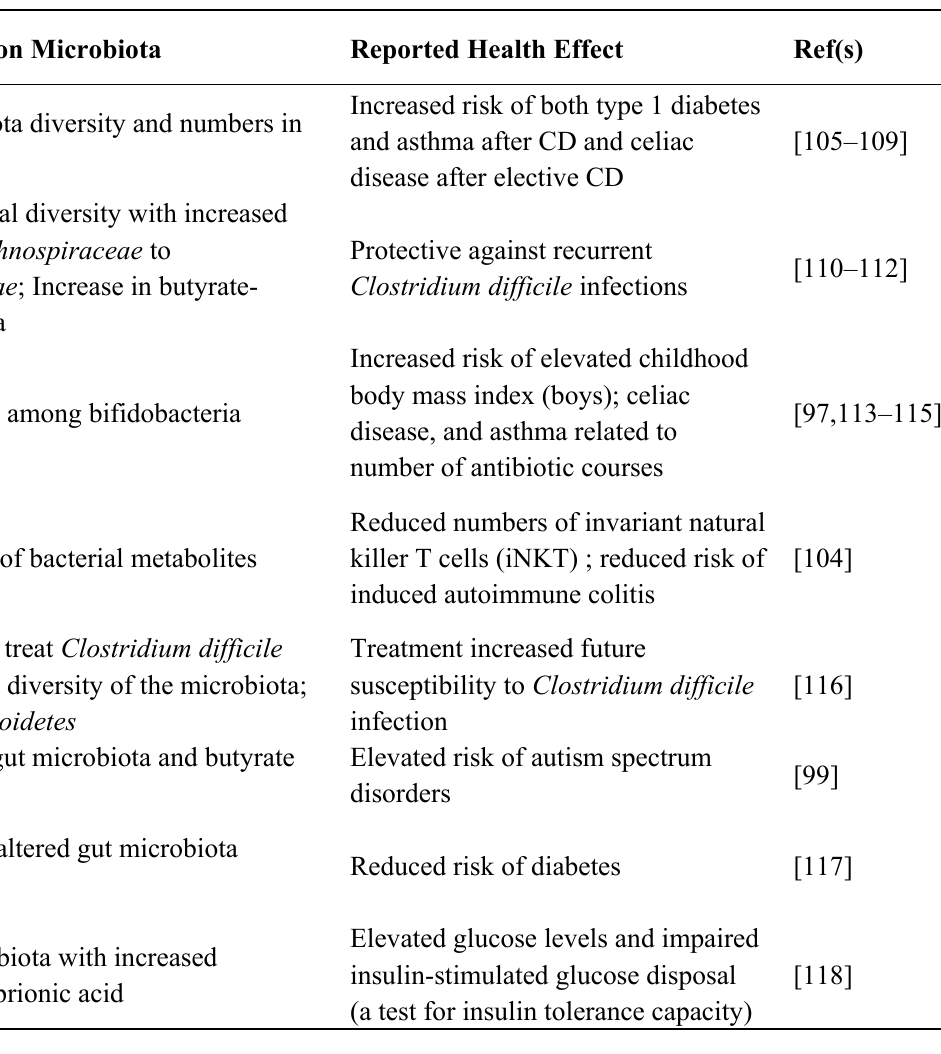
Table 2. Medical and various environmental factors reported to affect the